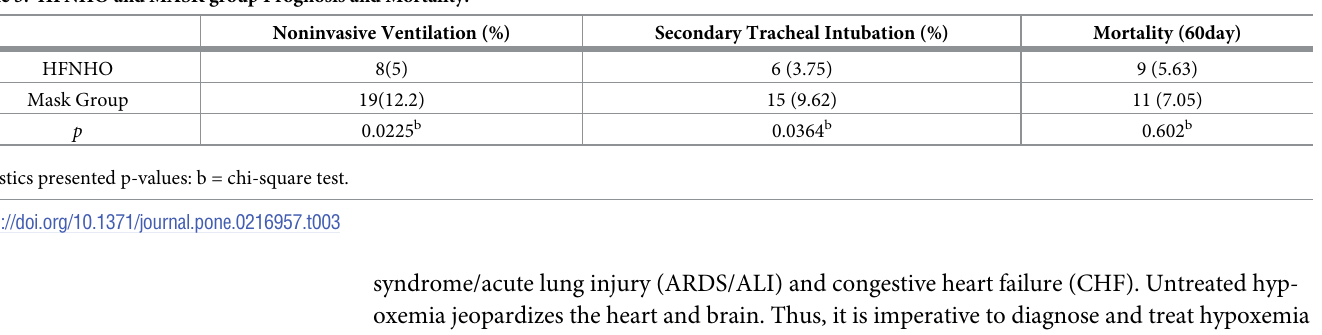
Table 3. HFNHO and MASK group Prognosis and